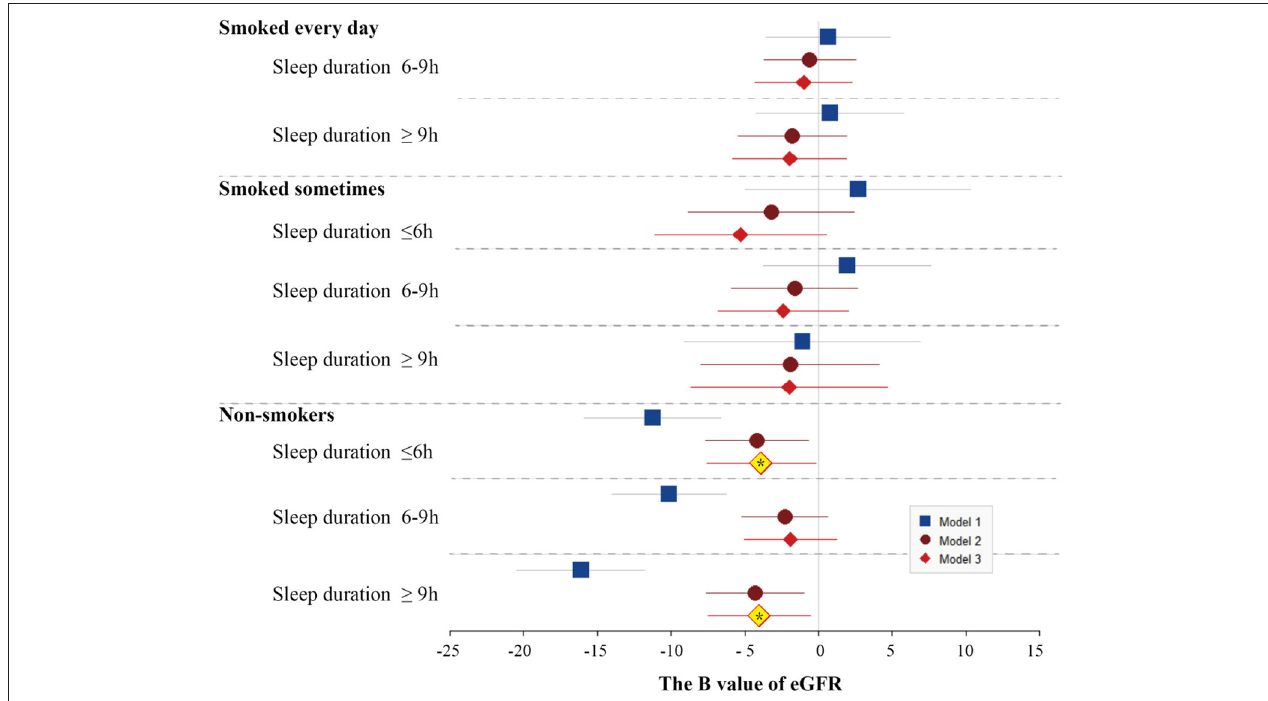
FIGURE 3 | Forest plots of B values of eGFR in the univariable and multivariable linear regression models among study population subgroups categorized by smoking and sleep duration. The subgroup of longer sleep duration and smoking every day was served as the reference group in the models. Model 1 was not adjusted. Model 2 was adjusted by age, race, BMI, and marital status. Model 3 was adjusted by age, race, BMI, marital status, frequency of snoring or breath cessation, diabetes, high blood pressure, high cholesterol, anemia, congestive heart failure, coronary heart disease, and